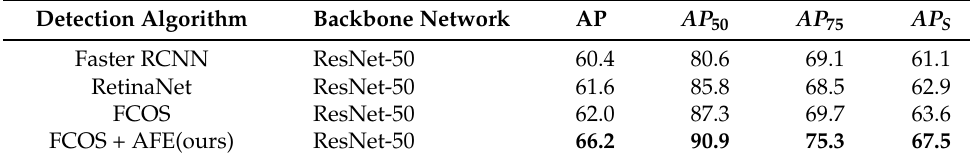
Table 5. Experimental results of the AFE Module on